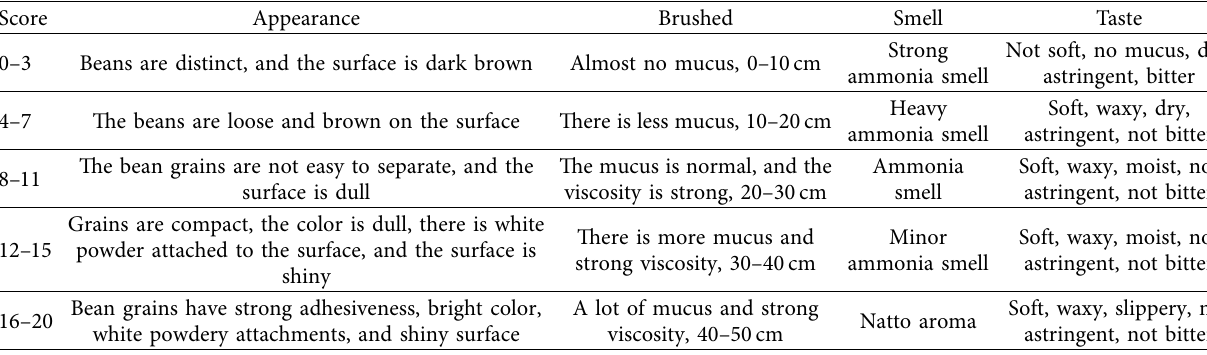
Table 1: Criteria for sensory